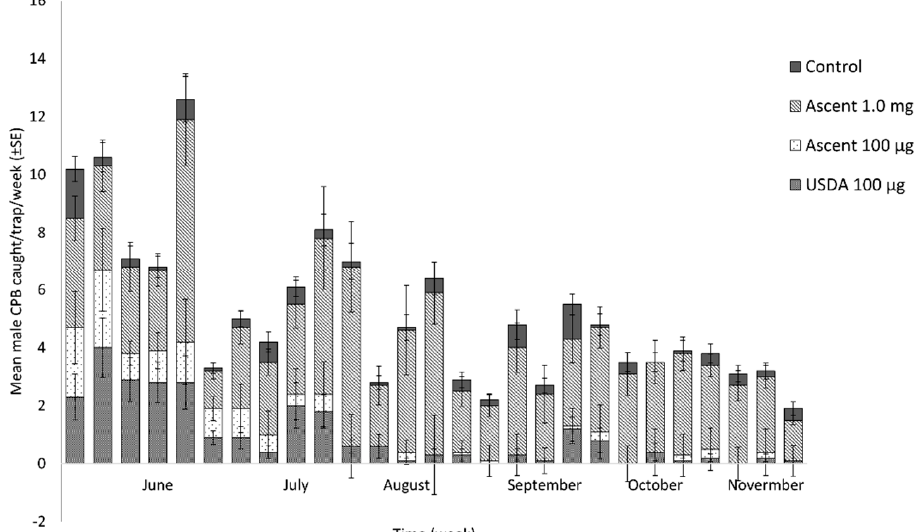
Figure 3. The flight activity and mean captures of CPB ( ± SE) in Delta traps baited with 100 μ g and 1 mg Alpha Scents pheromone blend and 100 µ g USDA blend in Insitu farm. The test was 1 mg Alpha Scents pheromone blend and 100 μ g USDA blend in Insitu farm. The test was con- ducted from May 2018 to November 2018 ( Experiment# 3), and traps were rotated weekly.